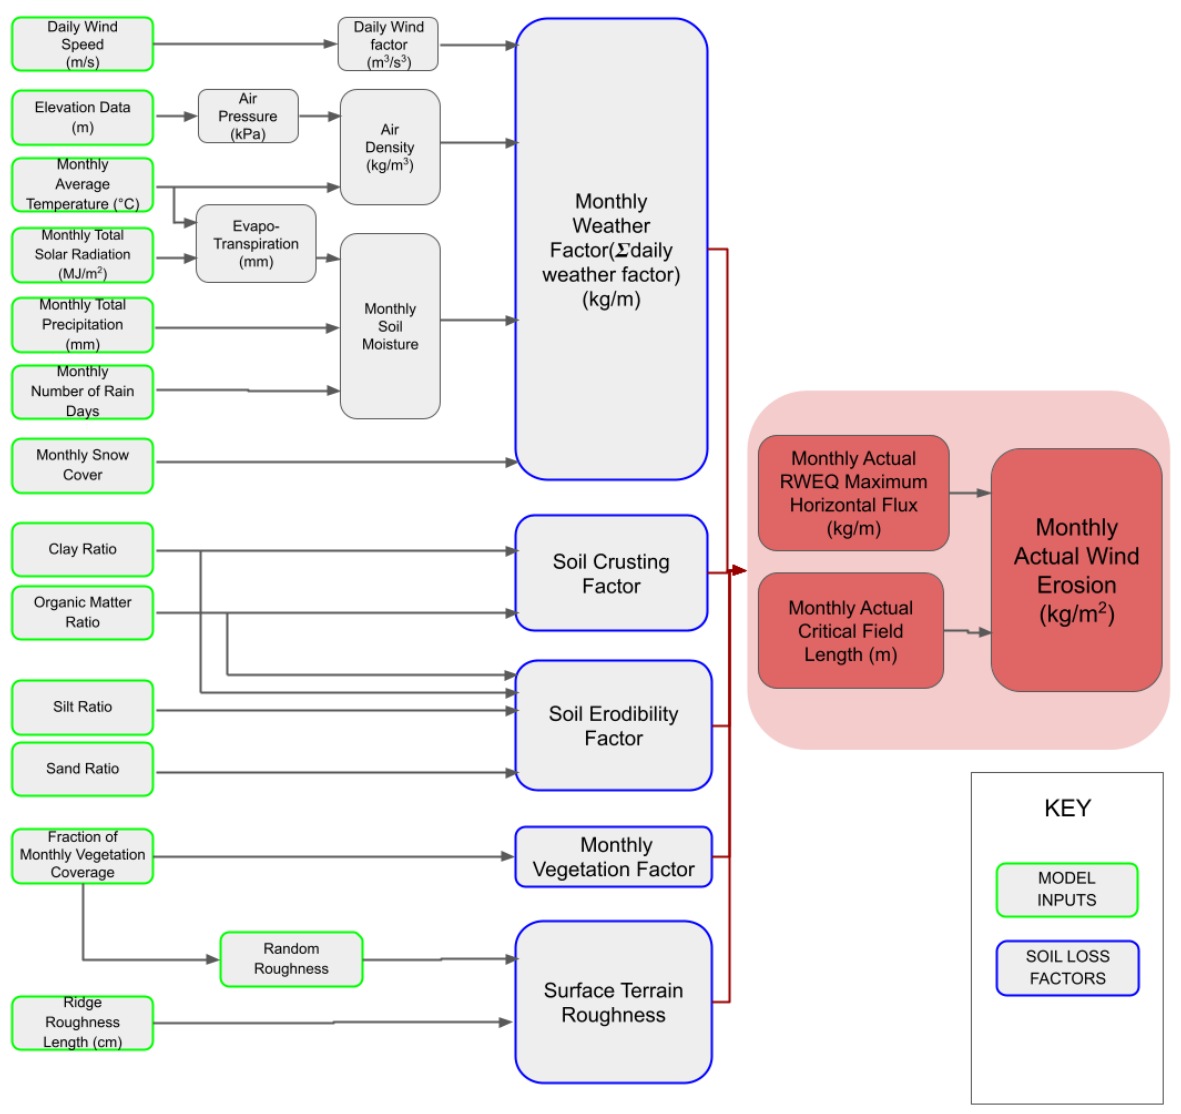
Figure 2. Model flowchart summary. Demonstrates how inputs are utilized to calculate factors used for final soil loss calculation.